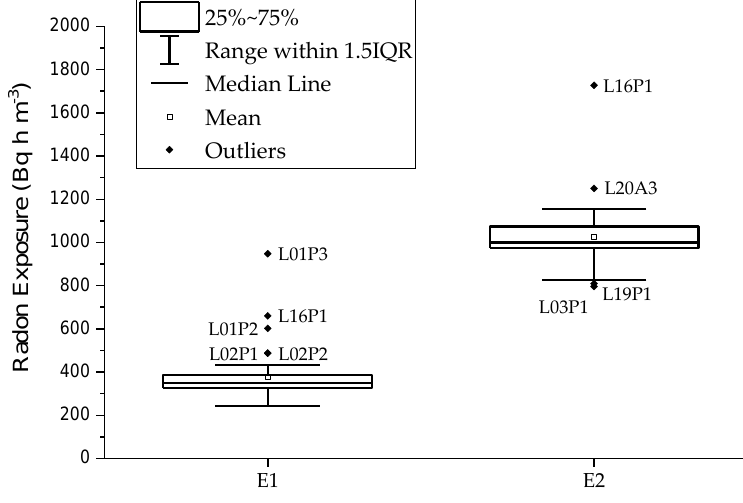
Figure 4. Boxplot diagram of the participant’s results for exposures E1 and E2. Outliers are identified.